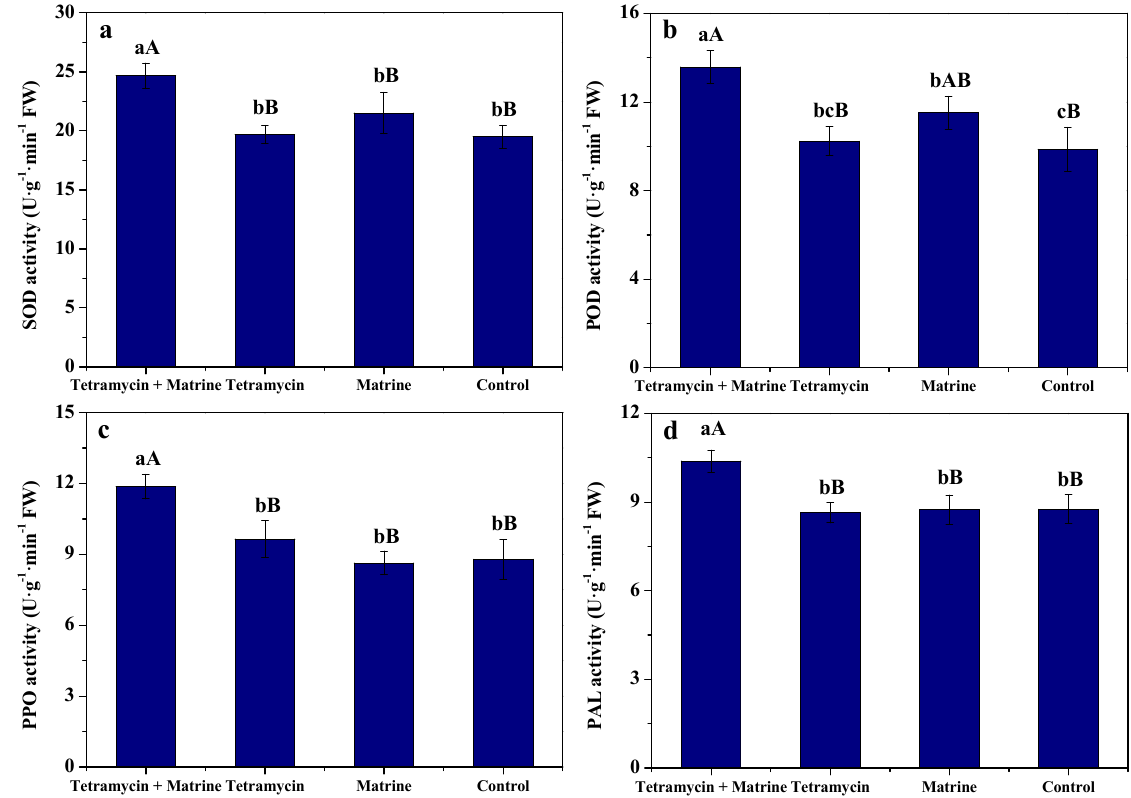
Figure 3. The effects of tetramycin and matrine on SOD ( a ), POD ( b ), PPO ( c ), and PAL ( d ) activities of kiwifruit fruits. Values indicate the mean ± SD ( n = 3). Different capital and small letters show significant differences at 1% ( p < 0.01) and 5% ( p < 0.05) levels, respectively.